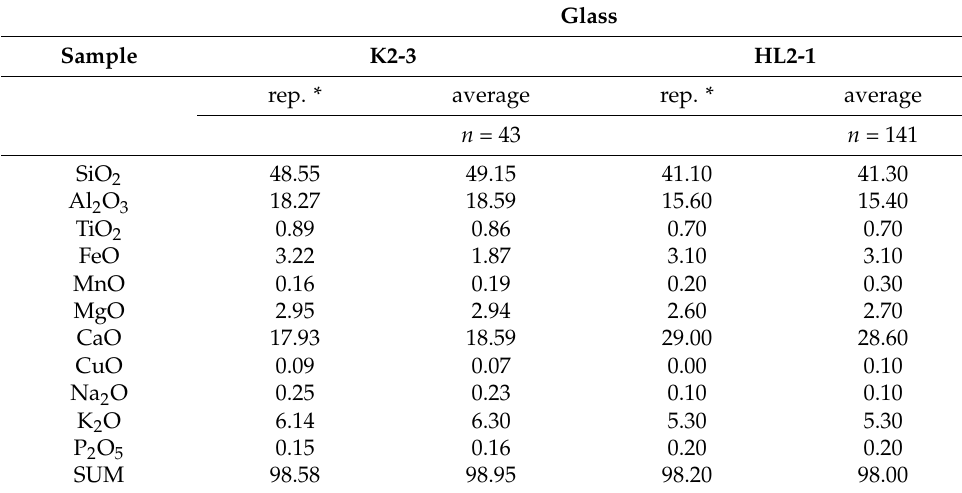
Table 3. Glass composition (Phase Assemblage I).